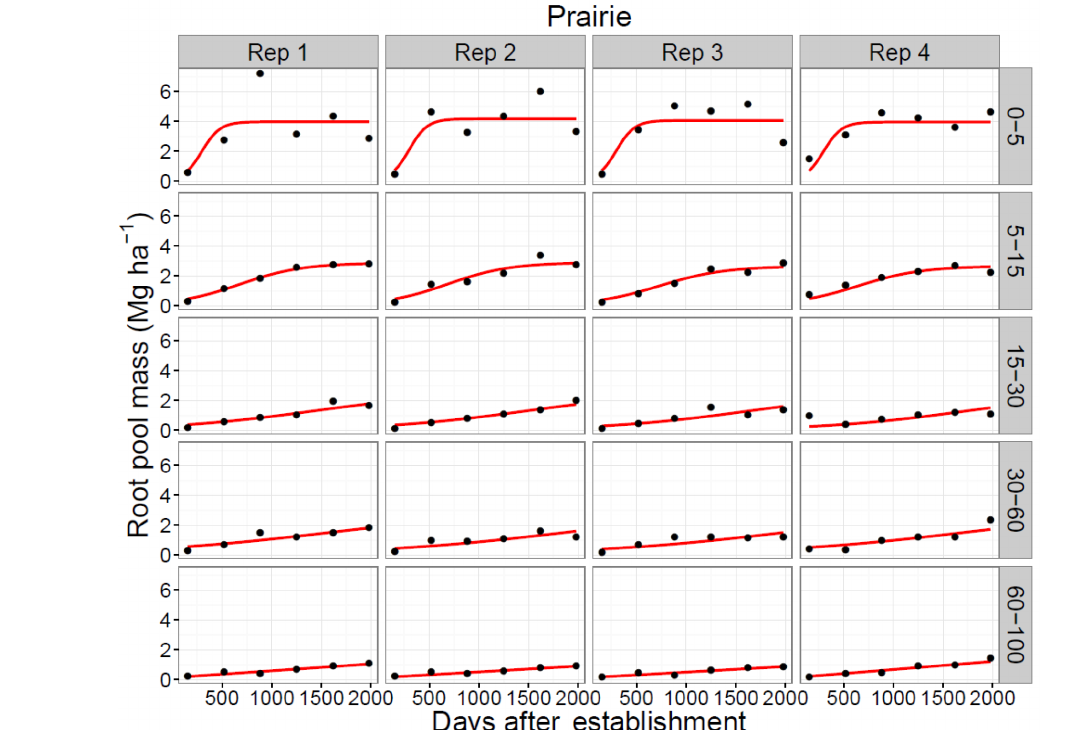
Figure A1. Logistic curves fit to root pool mass accumulation at each replication and depth increment in the prairie